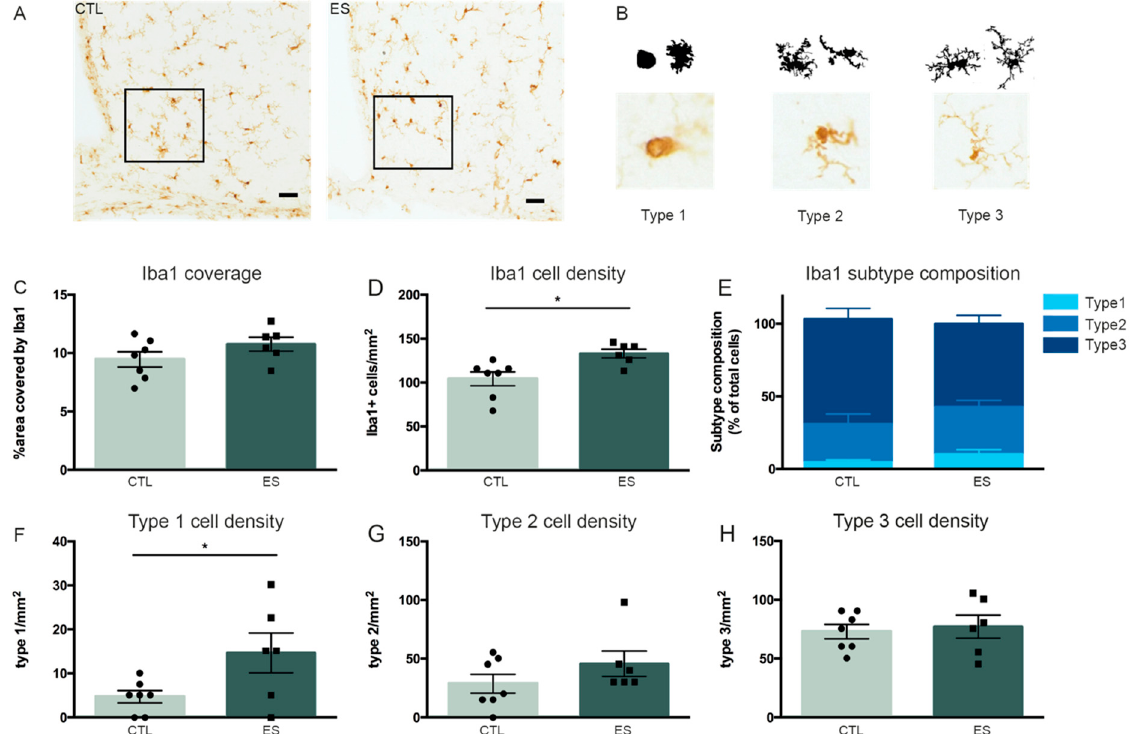
Figure 3. Microglia density is increased by ES at P9. ( A ) Representative images of Iba1 immunostaining and a defined region of interest (ROI; black square) in the arcuate nucleus of the hypothalamus (ARH). ( B ) Example illustrations of microglia subtypes. ( C ) Iba1 coverage is not affected by ES. ( D ) Iba1 cell density is increased directly after ES exposure. ( E ) ES does not alter Iba1 subtype composition at P9. ( F – H ) Iba1 subtype cell densities. ES increased type 1 cell density. Data are presented as mean ± SEM; scale bars 100 μ m; * condition effect; p < 0.05.